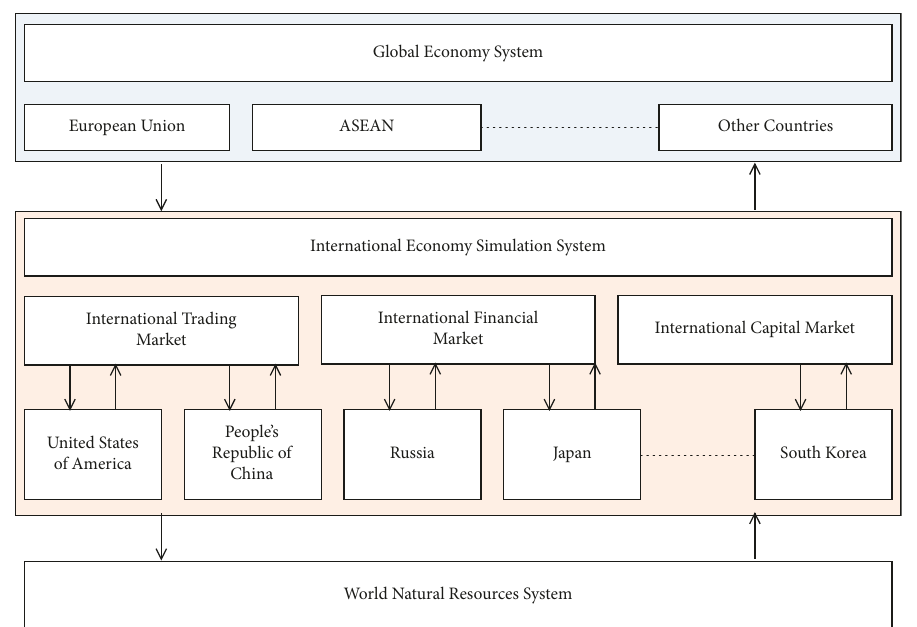
Figure 11: International economy simulation system (source: Guangzhou Milestone Software Co., Ltd.,